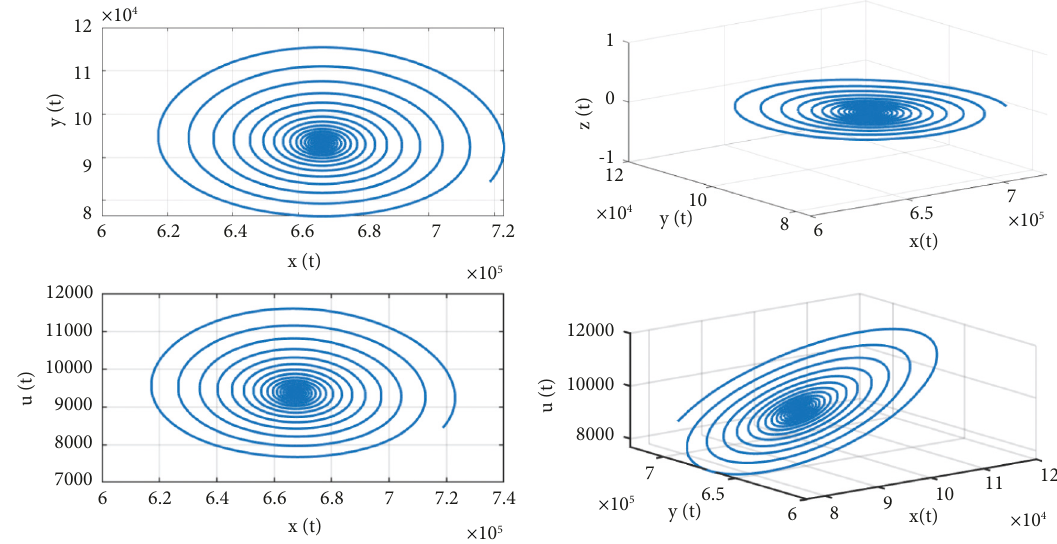
Figure 2: Stable responses for the time delay τ < 0 . 93.